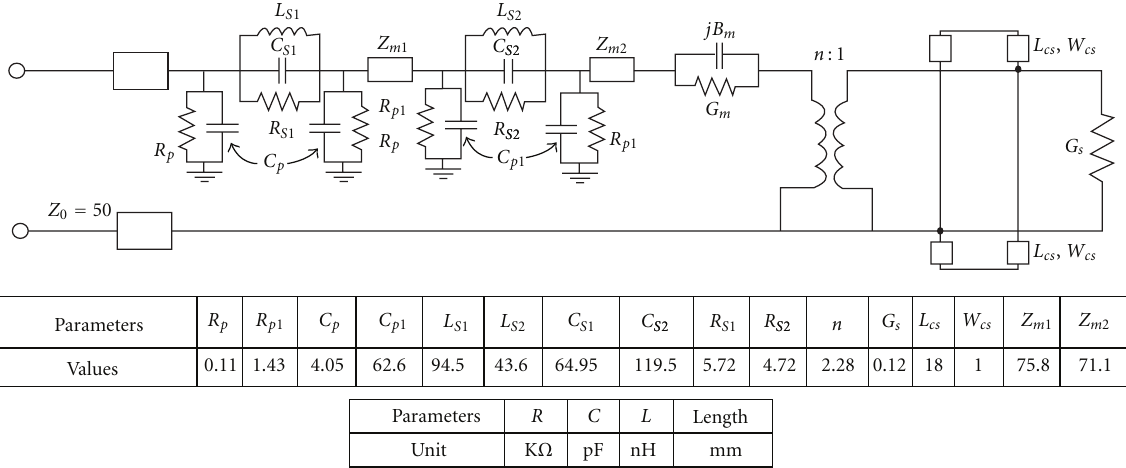
Figure 5: Circuit model for rectangular defected ground structure slot antenna.